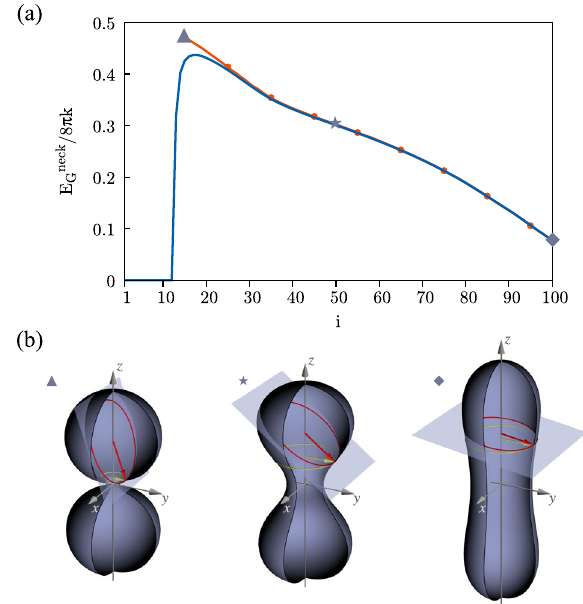
Fig. 3 Neck Gaussian energy. a Normalized Gaussian energy of the neck, E neck ð Z Þ = ð 8 π k Þ (Eq. (8)), along the MEP (blue line). The orange line with G dots provides the neck Gaussian energy as post-processing based on the sharp interface Canham – Helfrich energy (Eq. (1)), computed considering the ϕ = 0 levels set as the membrane mid-surface. The agreement between the two curves progressively deteriorates when getting closer to the saddle point, due to the increasing curvature of the membrane generatrix. In this region, the fi nite thickness of the bilayer plays a crucial role and is taken into account by the phase fi eld. b Three membrane con fi gurations sketching the upper (yellow) circular boundary of the neck with its curvature radius r ( Z ) (yellow arrow),andtheosculating (red) circle tothevesicle cross-section with the cutting plane passing through the neck boundary and containing both the surface normal and the tangent to the circle. The radius R n of the osculating circle is shown as a red arrow. Using these quantities, the sharp interface ð Z Þ = ð 8 π k Þ ¼ Canham – Helfrich energy reads E neck G ; CH position of each con fi guration along the MEP is denoted by the corresponding symbol (triangle, star, and